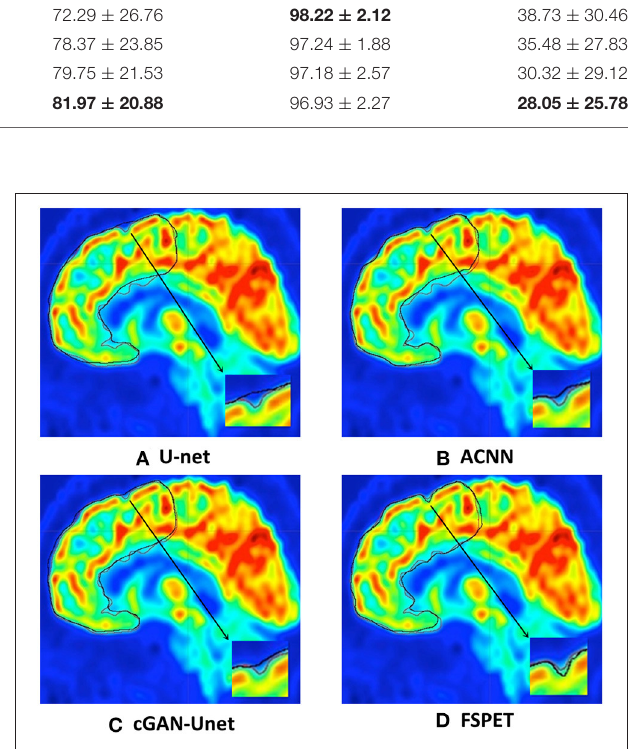
FIGURE 5 | Frontal cortex segmentation in median sagittal section of brain positron emission tomography (PET) imaging using U-net, ACNN, cGAN-Unet, and the FSPET model. Ground truth and predicted contour are in red and black, respectively. (A) U-net. (B) ACNN. (C) cGAN-Unet. (D)